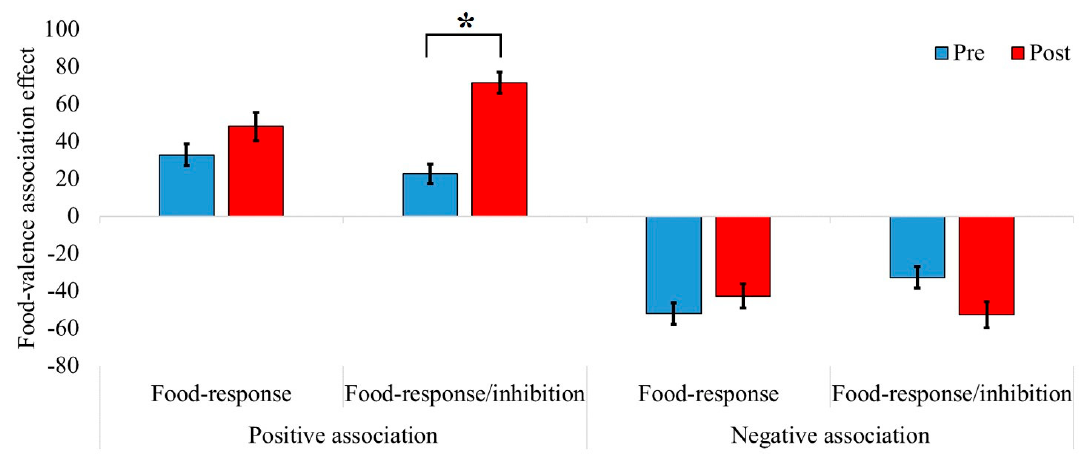
Figure 4. Differences in the food–valence association effect as a function of group, time, and valence. The food–valence association effect was calculated as mean response time (RT) in the non-food condition minus that in the food conditions. On the left panel (positive-valence condition) higher scores indicate greater positive associations whilst on the right panel (negative-valence condition) higher scores indicate greater negative associations. Error bars represent 1 standard error from the mean. * indicates p < 0.05.